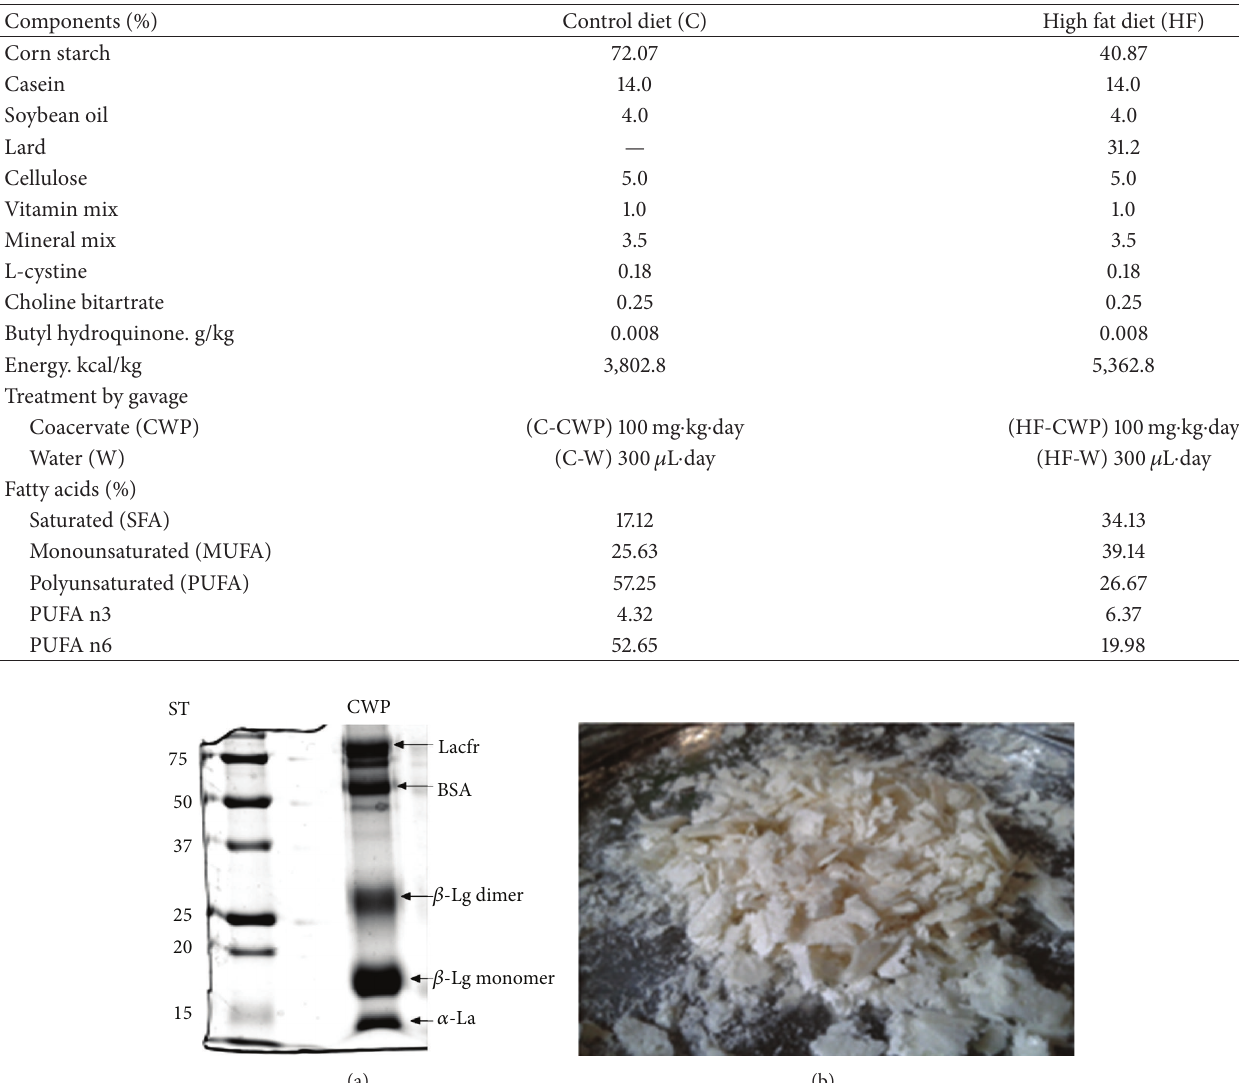
Table 1: Composition of the control diet and diet enriched with saturated fatty acids according to AIN-93. Coacervate was resuspended in 300 𝜇 L of water.